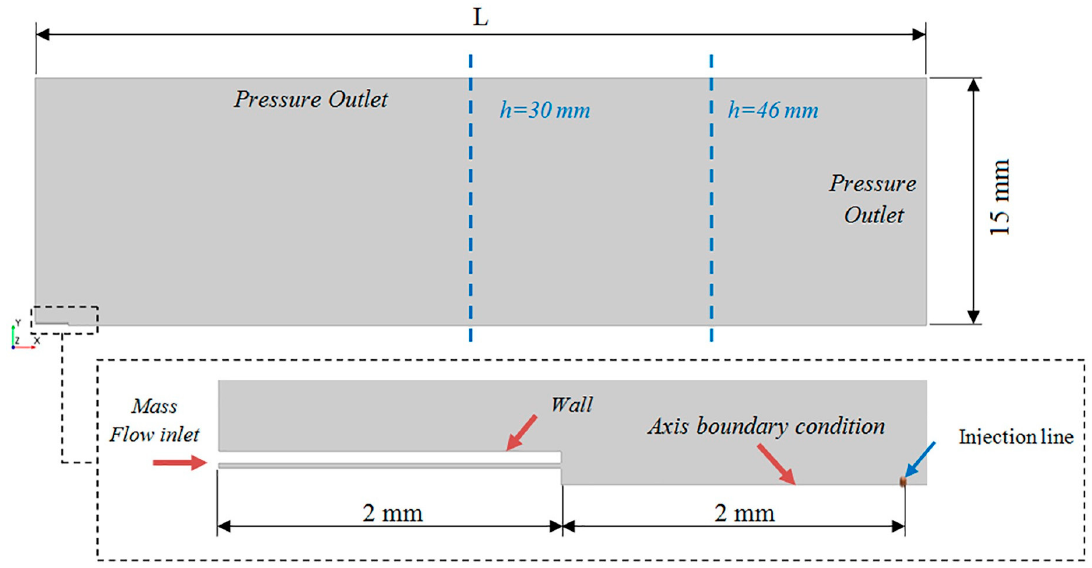
Figure 4. Cross section of the IC 1.1 tip ( a ) and the assumption defined for the generation of the axisymmetrical computational domain ( b ).